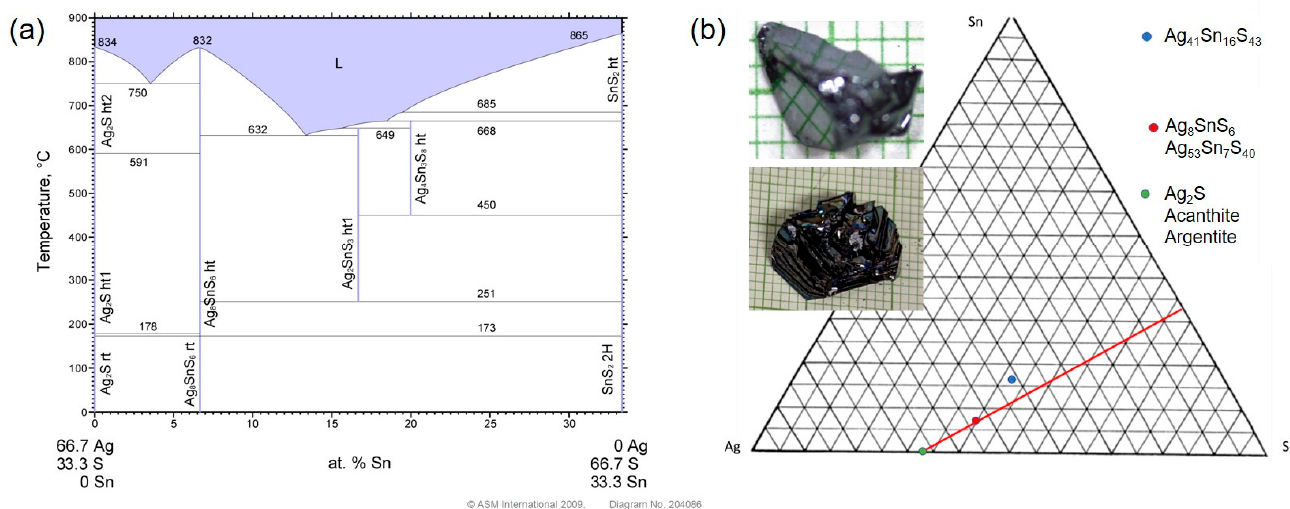
Figure 3. ( a ) Pseudo binary cut across the Ag-Sn-S ternary phase diagram (ASM diagram #204086) [40]. ( b ) Ternary Ag-Sn-S phase diagram with the ternary cut shown in ( a ) as a red line, Canfieldite (Ag 8 SnS 6 ) shown as a red dot, Ag 2 S shown as a green dot and our starting melt composition shown as a blue dot. In ( b ), the upper and lower insets are pictures of a canfieldite (Ag 8 SnS 6 ) and argyrodite (Ag 8 GeS 6 ) crystals on mm